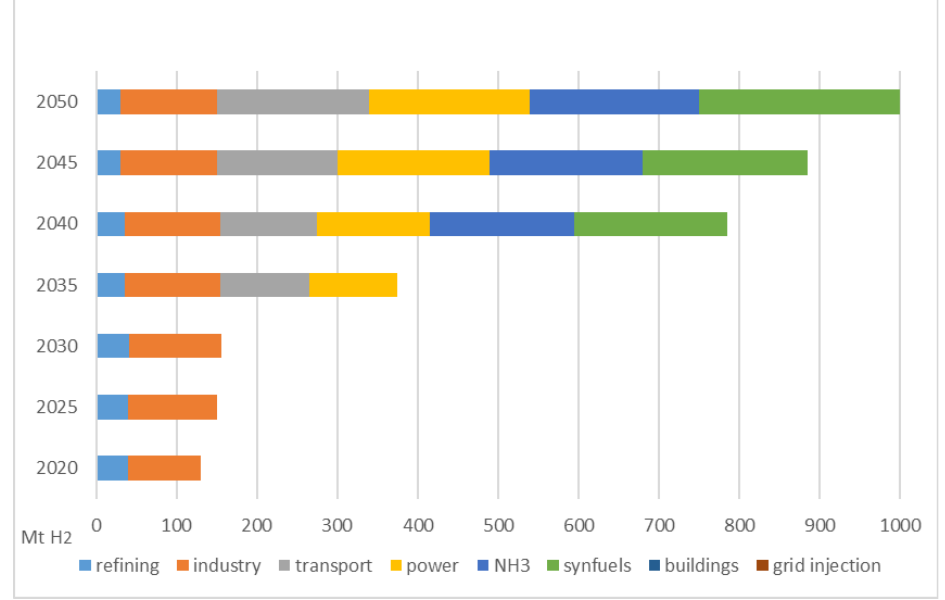
Figure 7. Announced Pledges Scenario [59].